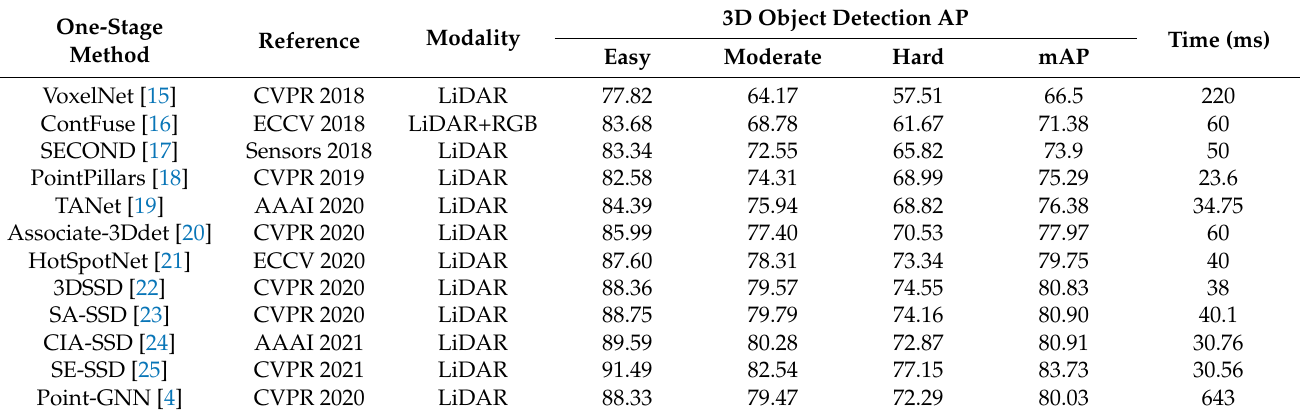
Table 1. Performance comparison of the KITTI test set by submitting to the official test